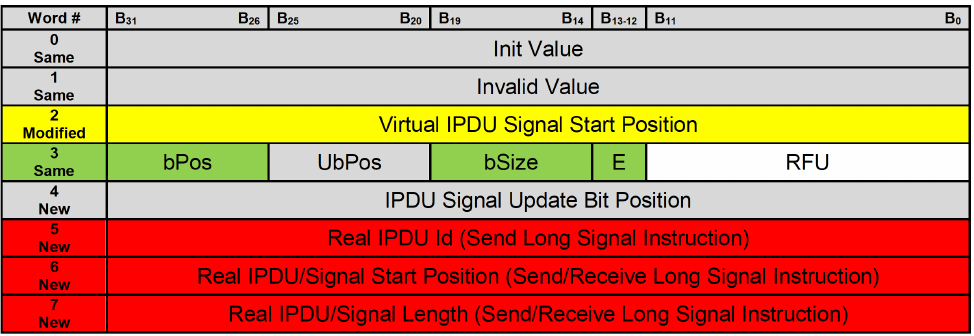
Figure 4. Encoding of properties for virtual signals inside the rom_n